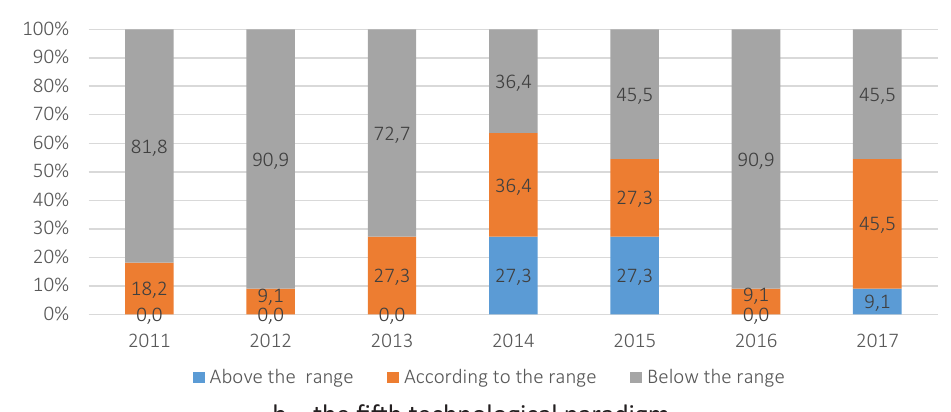
– the fifth technological Figure 3. Distribution of machine-building enterprises according to the level of the production subsystem dynamic development in terms of project implementation consequences,